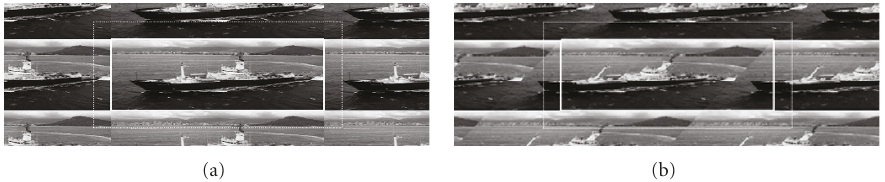
Figure 8: Boat image obtained from the original image of size 100 × 300 with periodic extension by downsampling using matrices (a) D 0 and (b) P 0